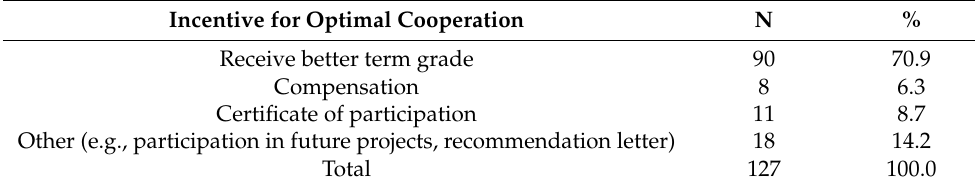
Table 2. Incentive for optimal cooperation.